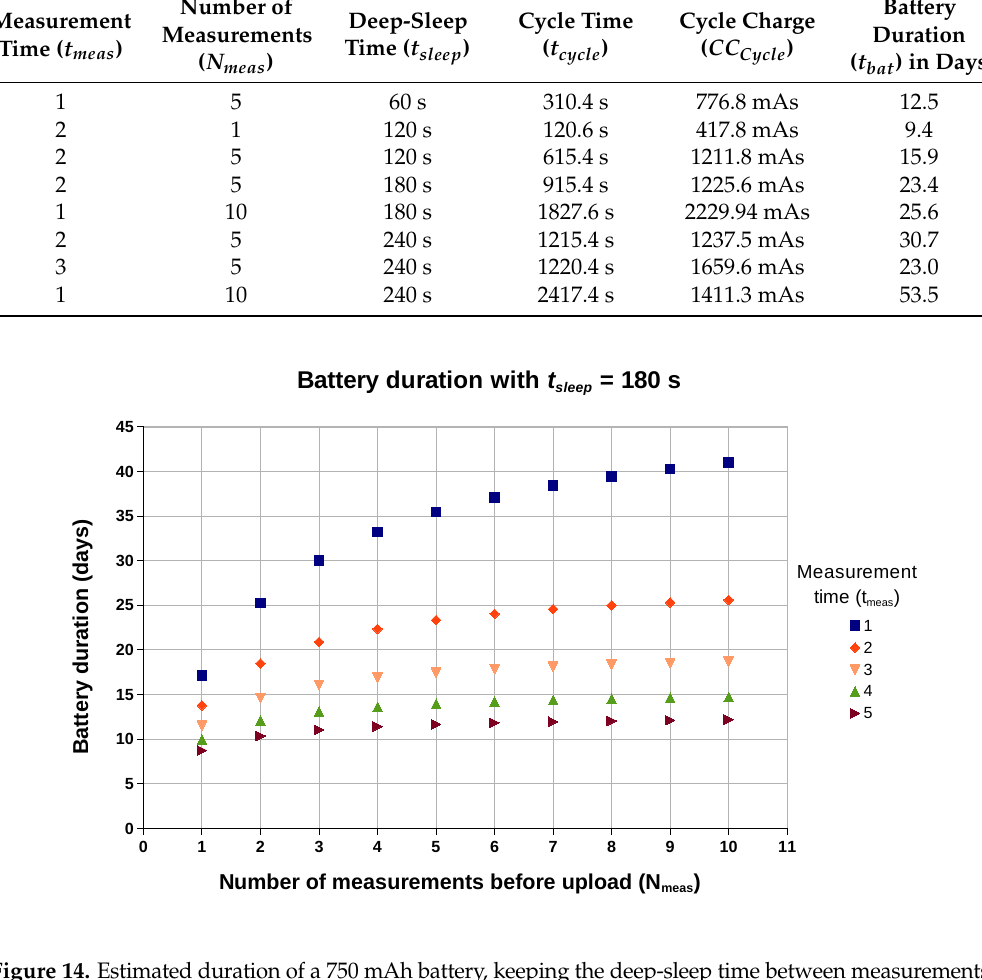
Figure 14. Estimated duration of a 750 mAh battery, keeping the deep-sleep time between measurements ( t sleep ) equal to 180 s, as a function of N meas and t meas